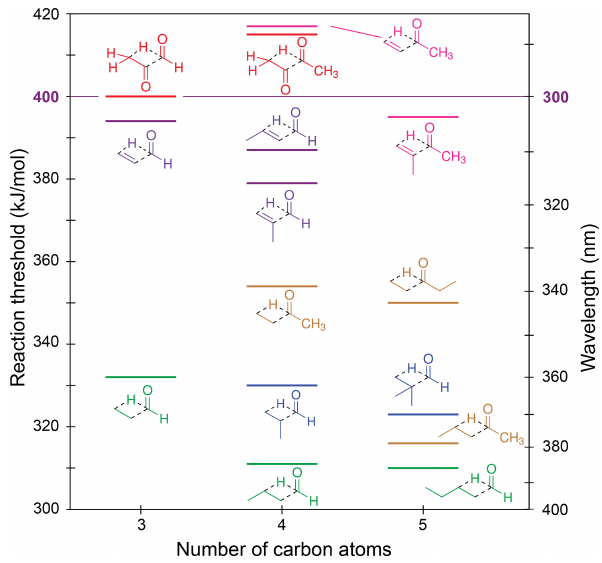
Figure 6. Zero-point vibrational-energy-corrected B2GP-PLYP- D3/def2-TZVP S 0 Norrish type III